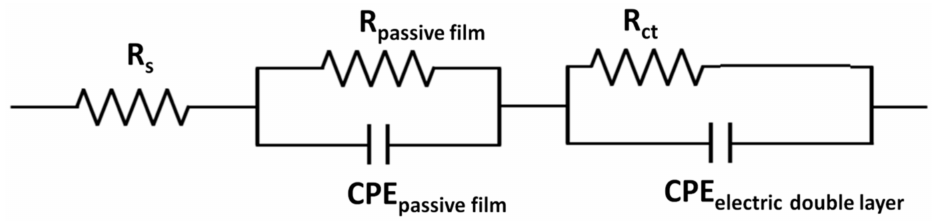
Figure 4. Equivalent Randles-type electrical circuit proposed for modeling processes at the alloy sample-type working electrode interface after casting